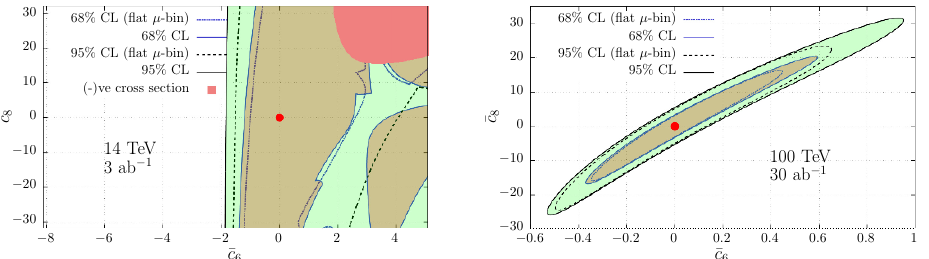
Figure 13 . Expected 1 (cid:27) and 2 (cid:27) bounds in the ((cid:22) c 6 ,(cid:22) c 8 ) plane at 14 (left) and 100 TeV (right), assuming (cid:22) c true